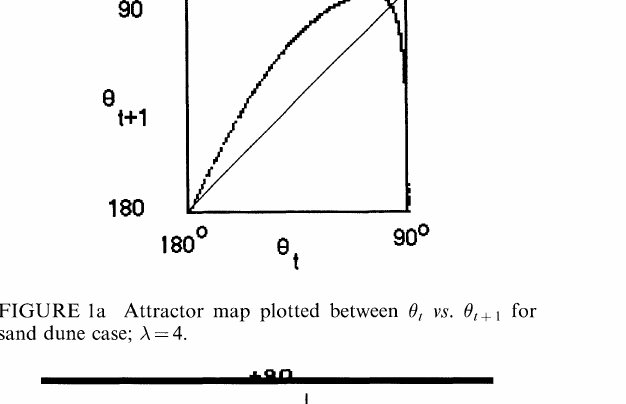
FIGURE la Attractor map plotted between 0t vs. Or+ for sand dune case; A 4.